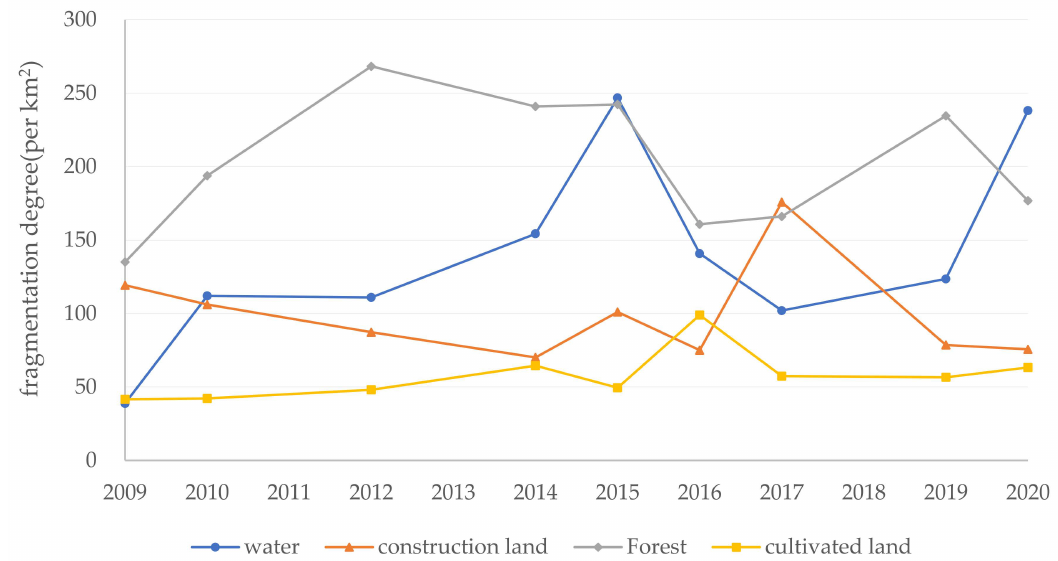
Figure 9. Fragmentation of different types of land use.